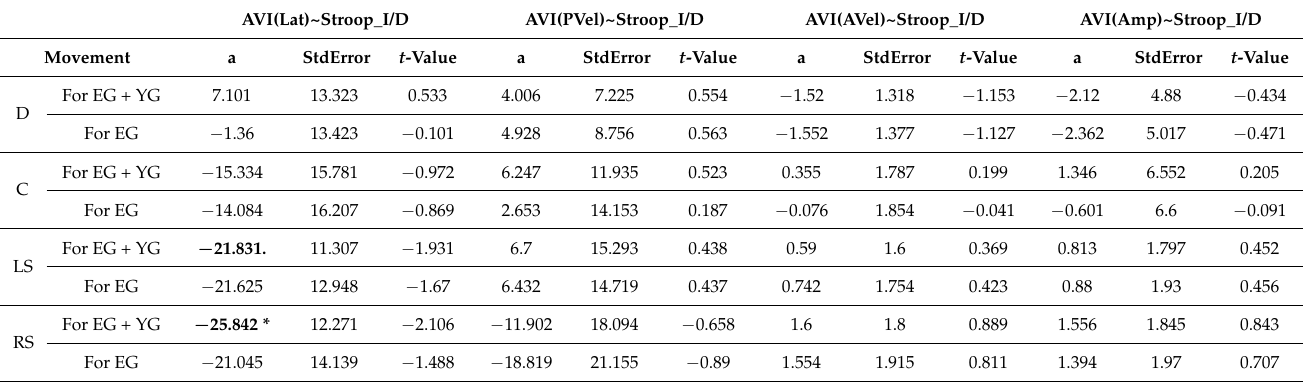
Table 5. Relations between AVI(Lat) and Stroop scores.